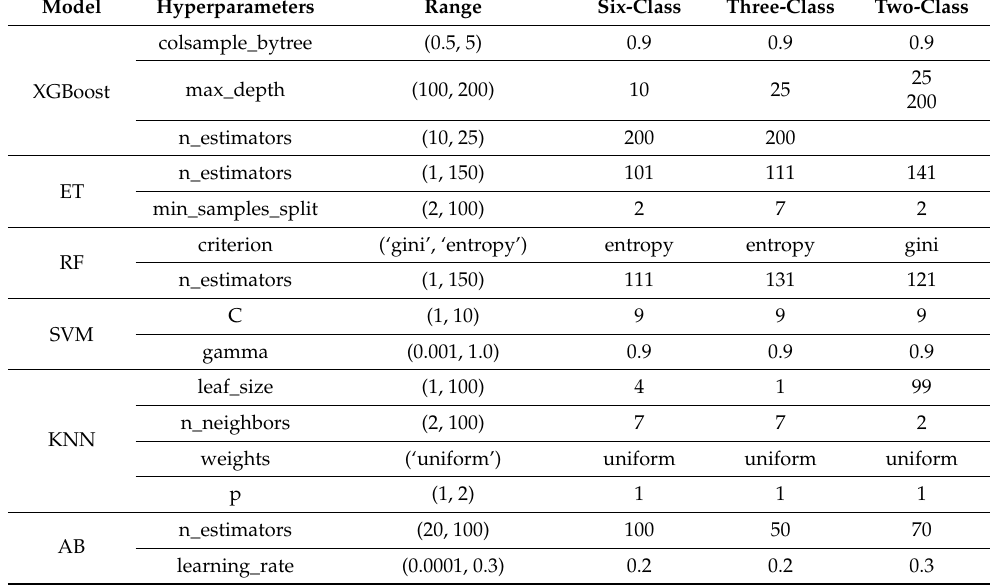
Table 3. A set of hyperparameters for six ML models, the ranges used for model optimization, and the best values obtained for three classification